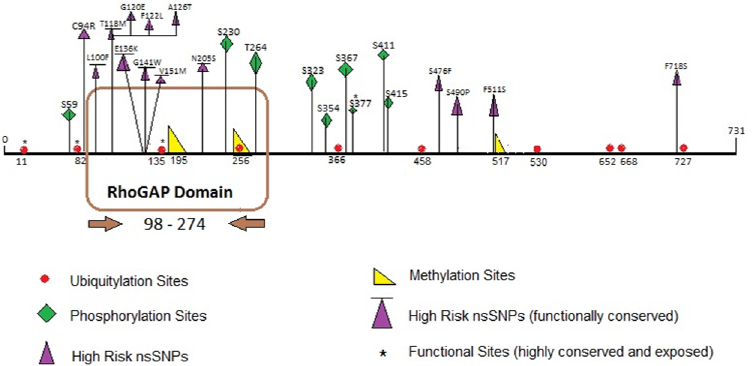
Fig 5. Putative PTM sites and high risk nsSNPs in TAGAP protein. Schematic illustrationof locationsof high risk nsSNPs and PTMs (ubiquitylation, phosphorylation and methylation) in TAGAP protein. The nsSNPs that are also predictedas functionallyconservedby ConSurf are all present in the RhoGAP domainof the protein starting from L100F to N205S. The site K256 is predictedto undergoboth methylation and ubiquitylation.